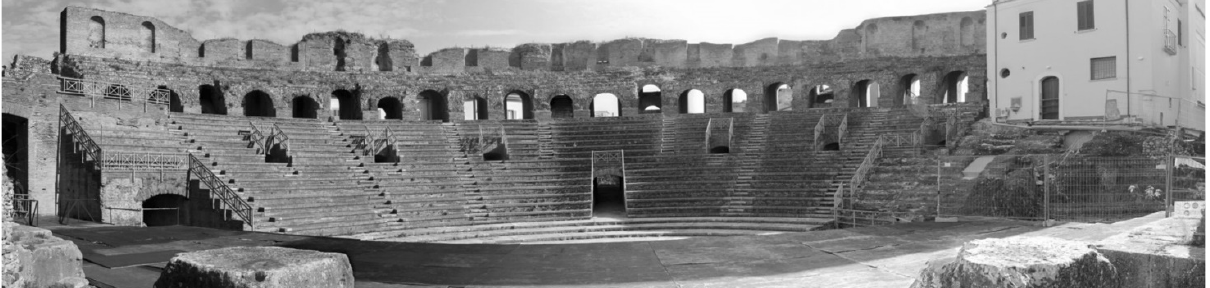
Figure 1: The Roman theatre of Benevento, the